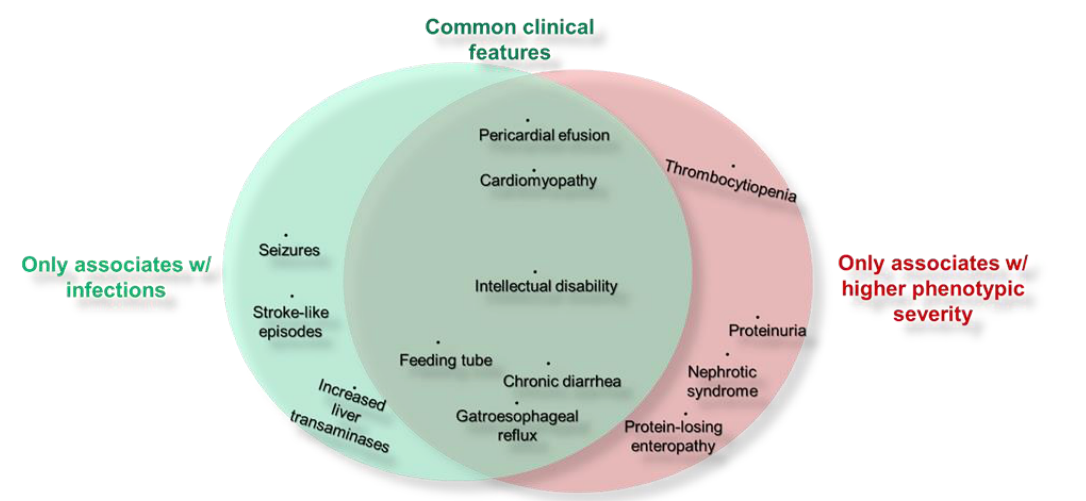
Figure 5. Association between infections, overall phenotype severity and other PMM2-CDG clinical features. Infections and increased overall phenotypic severity significantly correlated with a set of common clinical signs (represented in the middle part of the figure). However, there are clinical features which only significantly segregated with infections (seizures, SLE and increased liver transaminases) or increased phenotypic severity (thrombocytopenia, nephrotic syndrome, and protein-losing enteropathy). Statistical significance calculated with Fisher’s exact test. All p values and OR for each clinical manifestation are available in Tables S9 and S10.